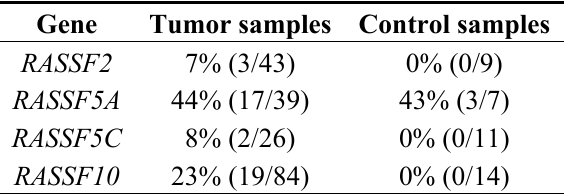
Table 1. Summary of methylation